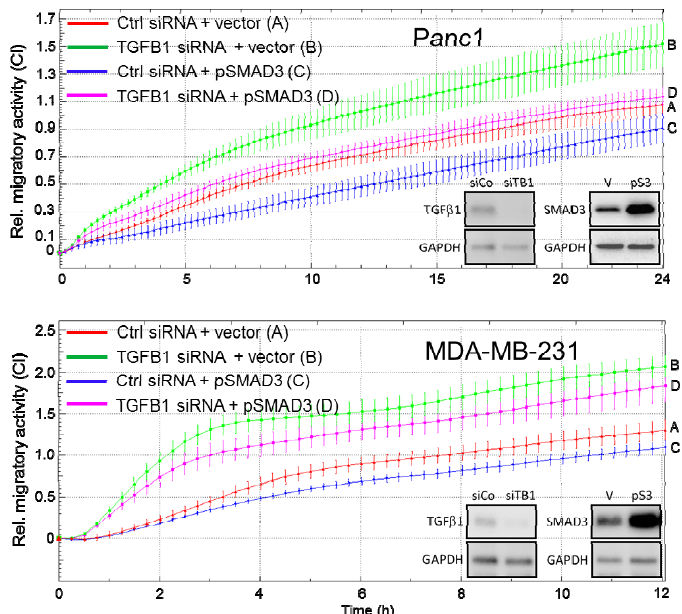
Figure 5. E ff ect of ectopic SMAD3 expression on cell migration following RNAi-mediated depletion of endogenous TGF β 1. Panc1 or MDA-MB-231 cells were transfected with 50 nM each of either ctrl siRNA or TGFB1 siRNA in combination with either empty pcDNA3.1 vector or pcDNA3.1 containing a SMAD3 cDNA. Forty-eight h after transfection cells were analyzed by real-time cell migration assay. Data are the means ± SD of parallel 3-4 wells and are representative of 3 independent experiments. The di ff erences between curves D and B were first significant ( p < 0.05) at 3:30 (Panc1) or 3:00 (MDA-MB-231), and for Panc1 cells remained significant over the 24-h assay period. A transient e ff ect of ectopic SMAD3 was also seen in control conditions (curves A vs. curves C, significant between time points 6:30 and